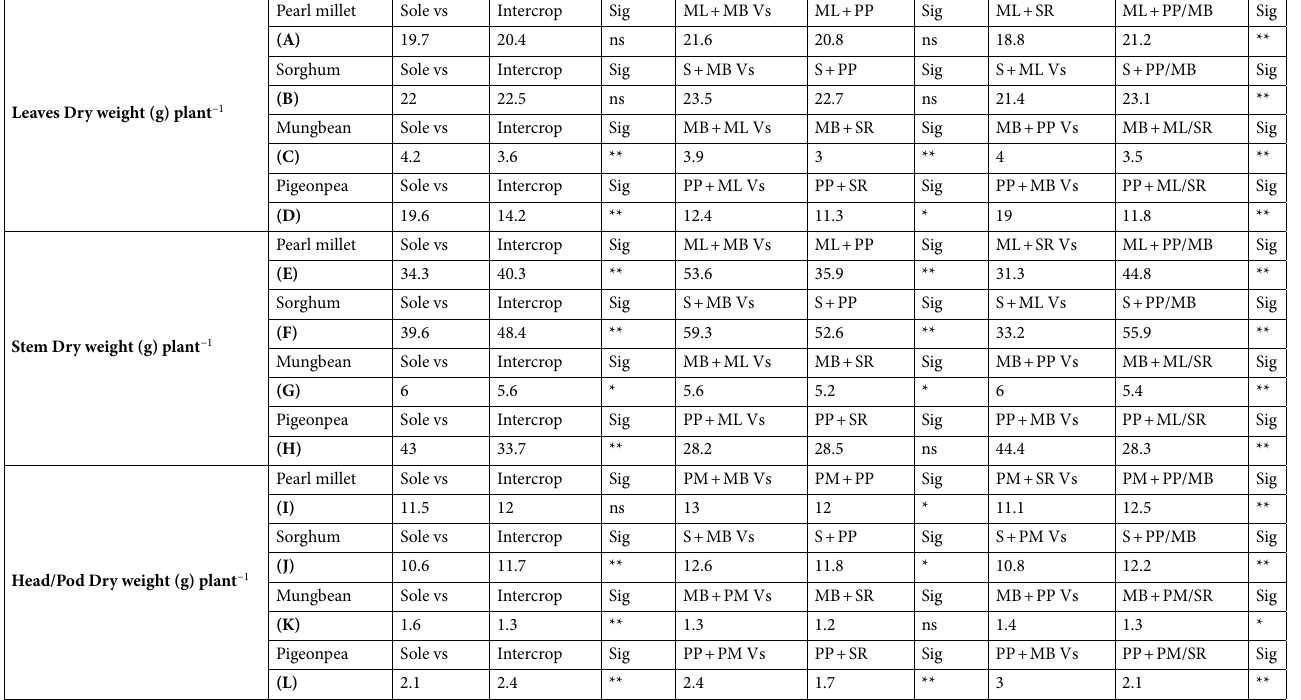
Table 6. Pre-planned comparison of different intercropping systems at anthesis of summer crops as affected by intercropping and irrigation regimes. Where ns, ** stands for non-significant and significant at 1% level of probability, respectively. PM, MB, S and PP stand for millet, mungbean, sorghum and pigeon pea, respectively. Means in the same category are not significantly different if followed by at least one common letter at ( P ≤ 0.05) level.